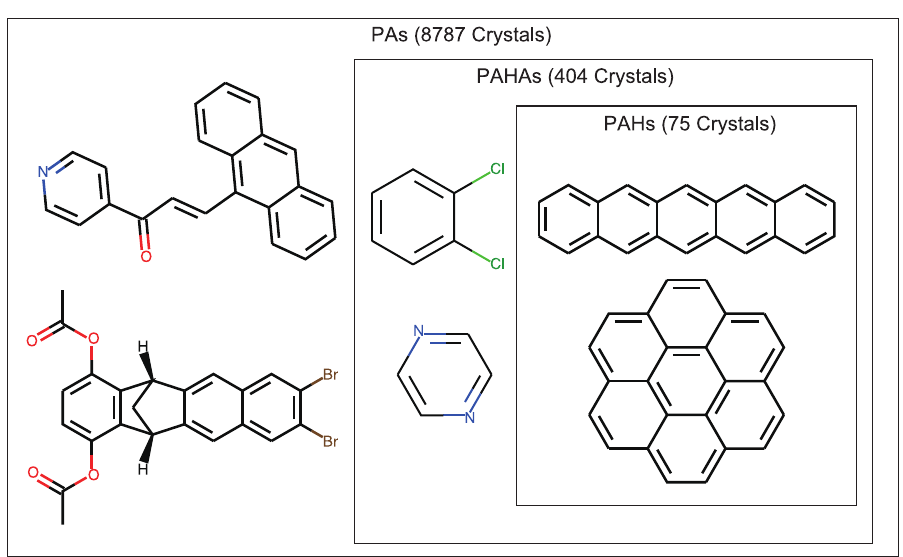
Fig 5. Dataset of organic molecular crystals. The three datasets correspond to polycyclic aromatic hydrocarbons (PAHs), polycyclic aromatics with hetero atoms (PAHAs), and polycyclic aromatics (PAs).